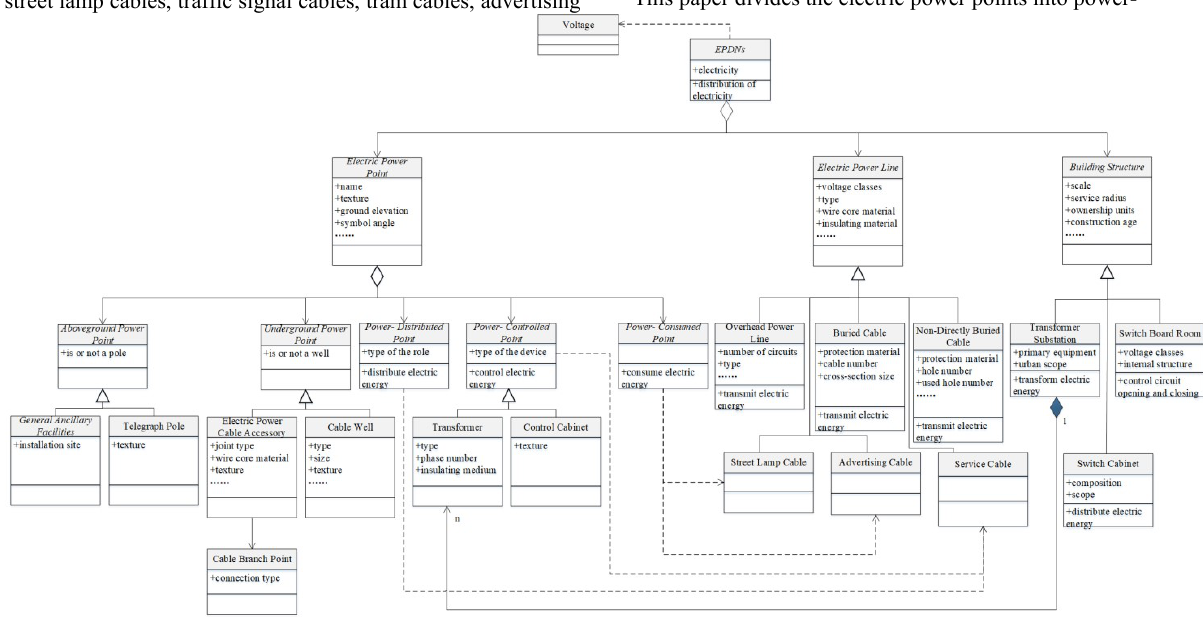
Figure 1. Structure system of